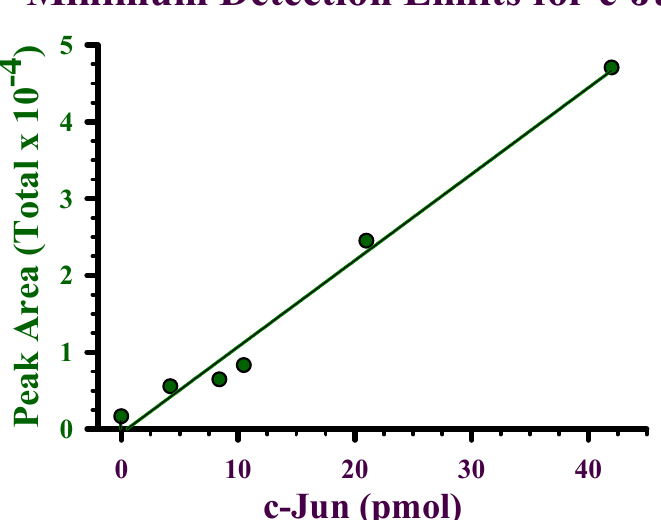
Figure 3. Linear increase in binding with increasing amounts of c-Jun incubated with 250 pmol AP-1 oligonucleotide. As little as 4.2 pmol c-Jun was detectable and oligonucleotide was not saturated by 42 pmol of c-Jun protein. Linear regression (y = ax+b, r 2 = 0.98) was used to fit the data